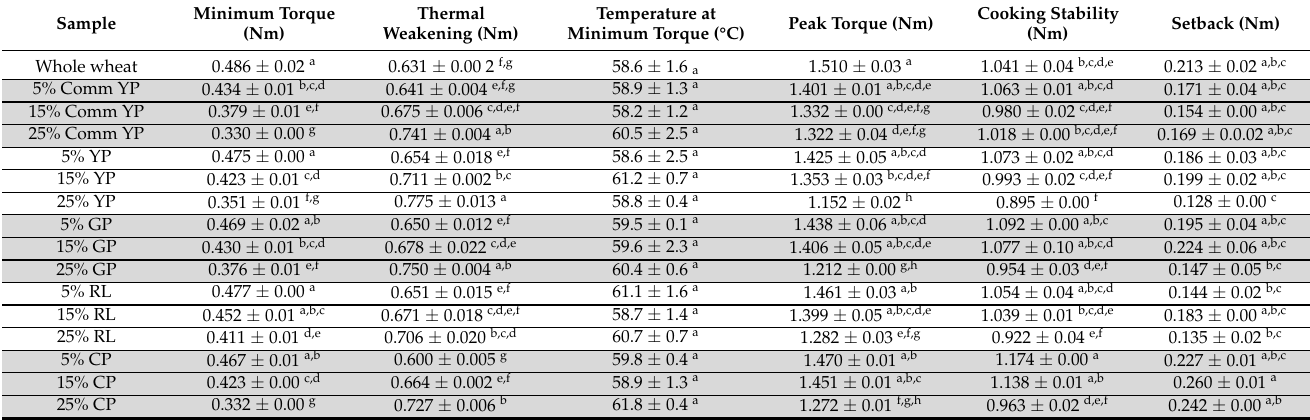
Table 3. Pasting characteristics of whole wheat/pulse flour blend from